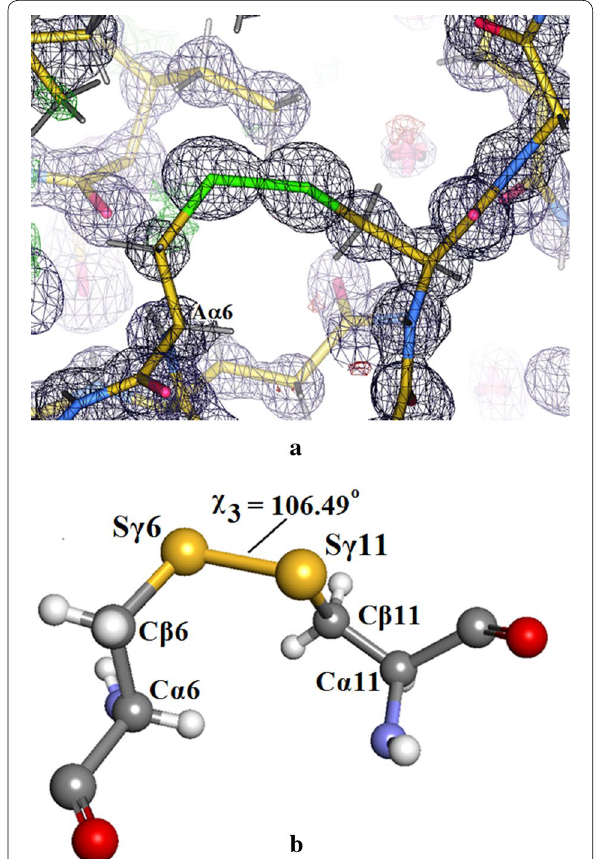
Fig. 15 a Electron density in the ordered internal S–S bridge Insugen (I) chain A(1) between Sγ6 and Sγ11. Drawn with WinCoot 0.7 [19]. b Insugen (I) structure: chain A(1) S–S bridge between Sγ6 and Sγ11 showing the geometry of the ordered S–S bridge after refinement.